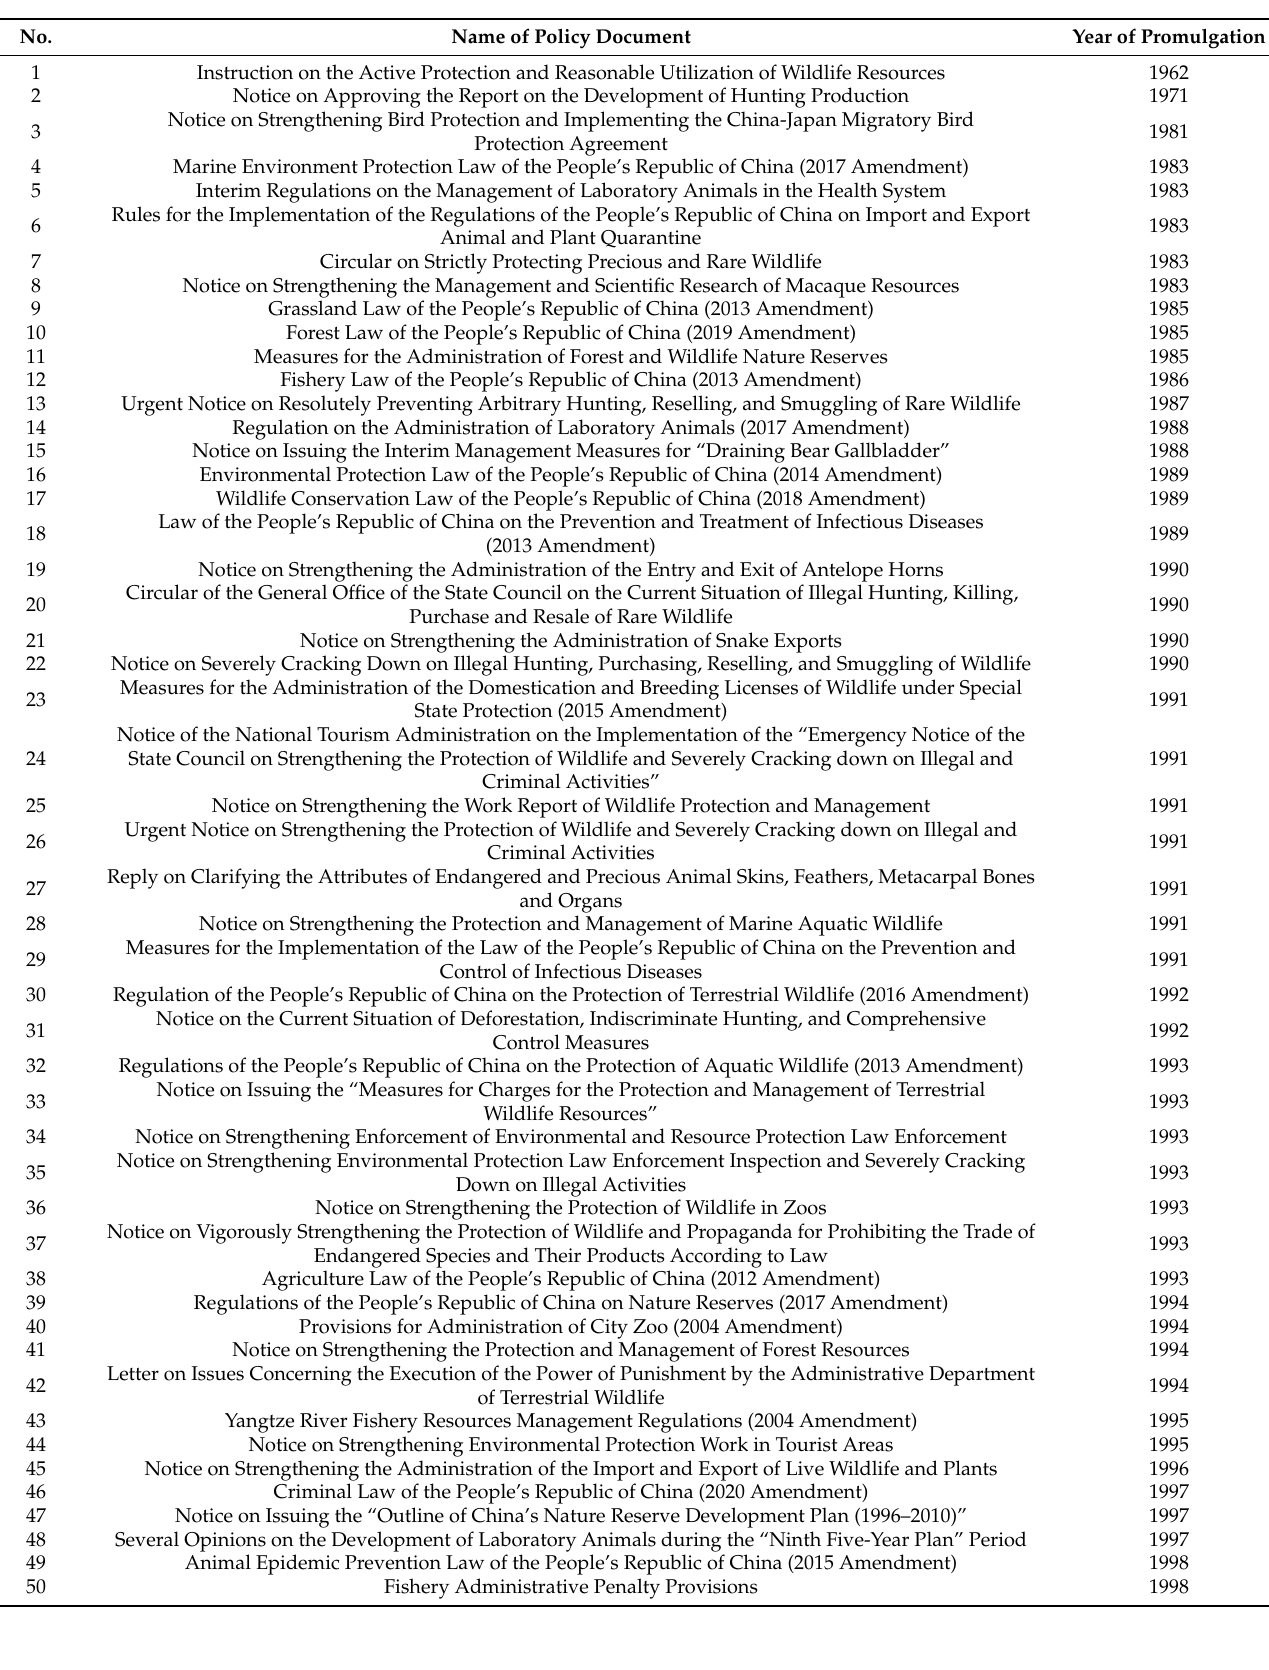
Table A1. China’s Wildlife Management